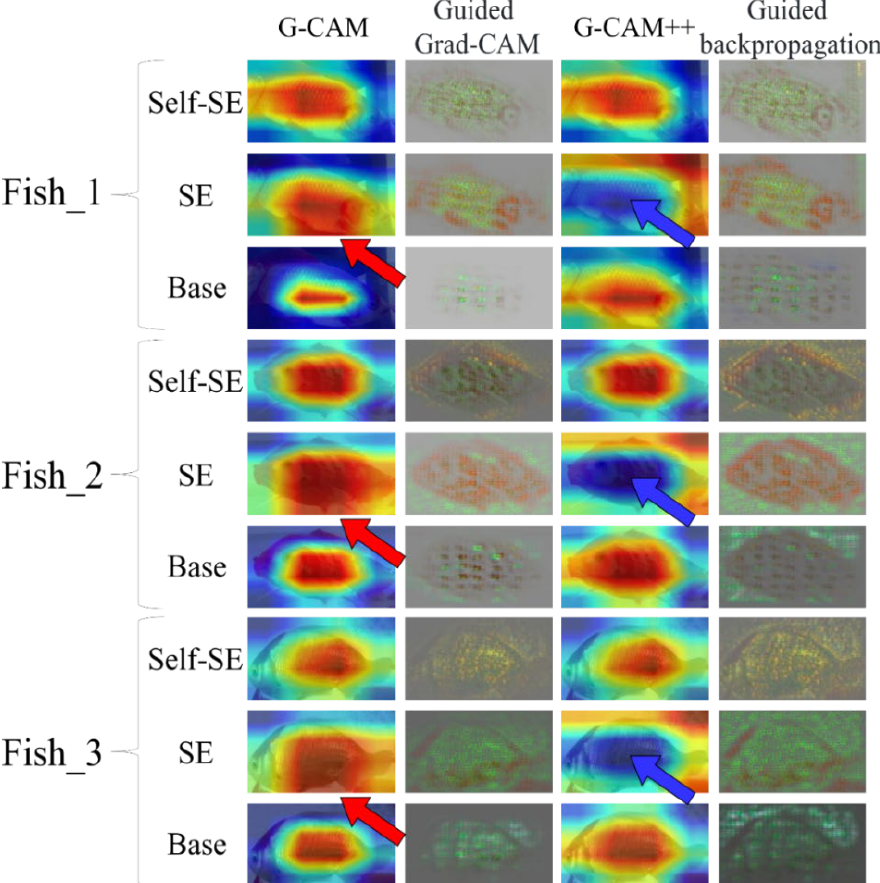
Figure 14. Self-SE module, SE module and base network for comparison using the activation heat map to view the model’s attention. A redder color means that the model is more interested in this area, and the blue (black) means that the model ignores this area. It is obvious that the self-SE module performs perfectly in different activation methods and different networks. The red arrows point to feature areas that the network should not pay attention to. The blue arrows point to feature areas that the network should pay attention to.